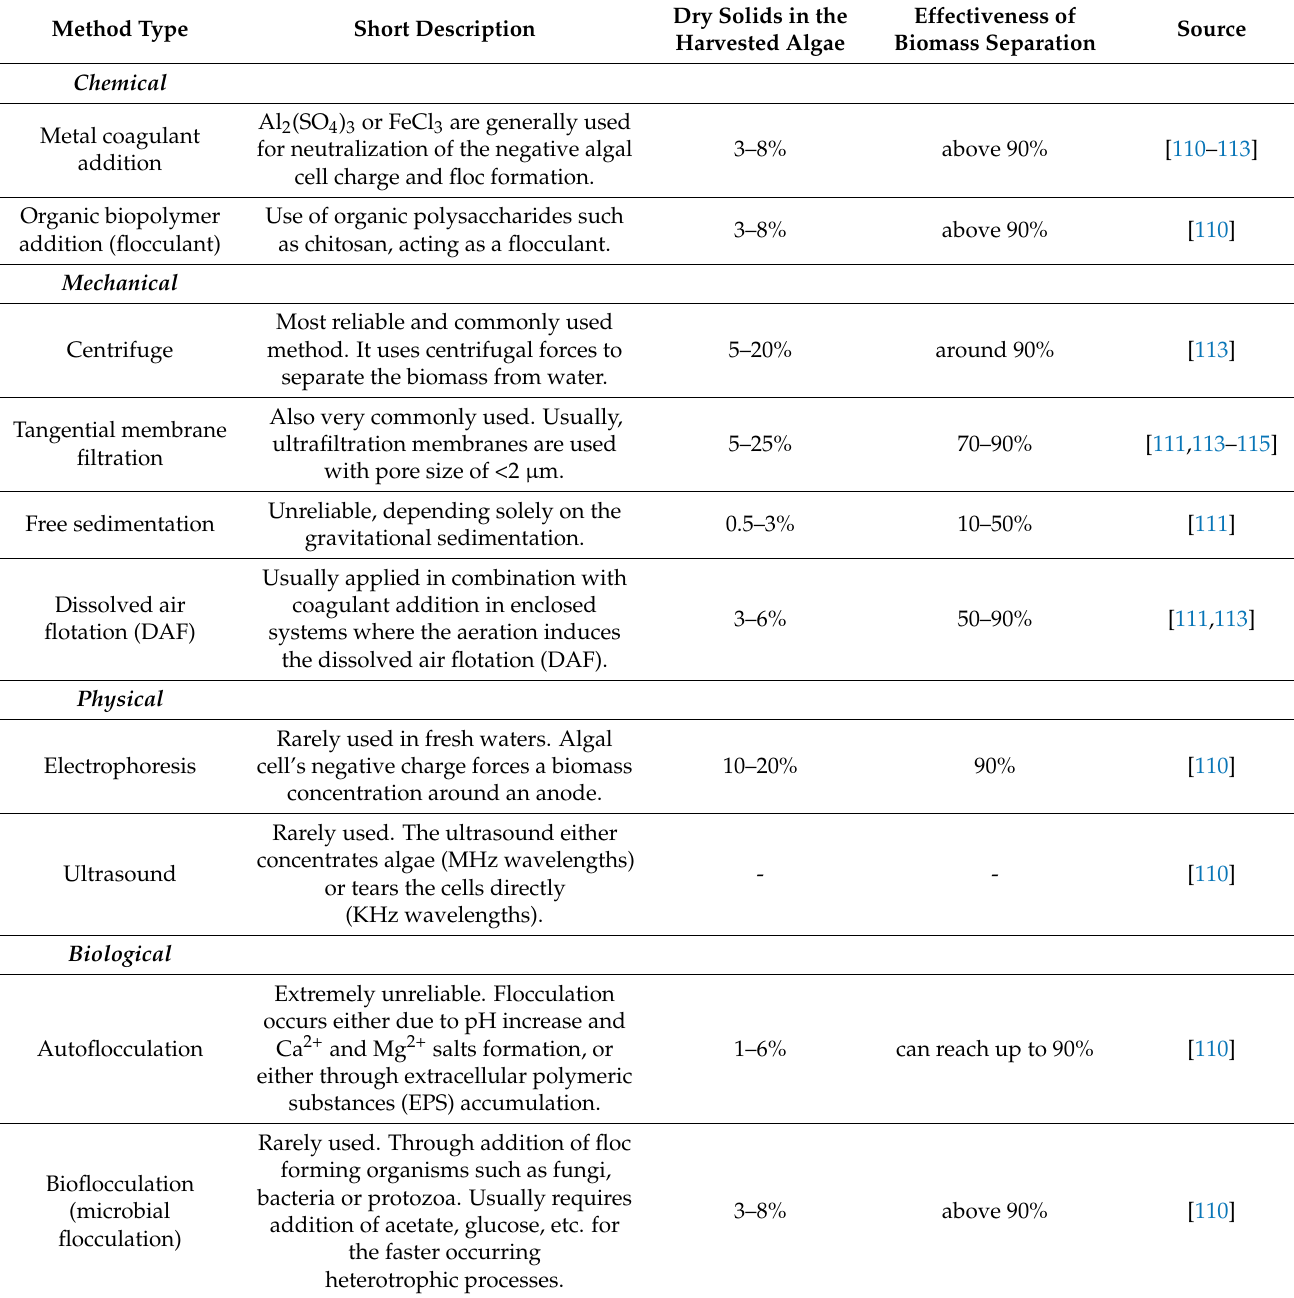
Table 4. Algae harvesting methods for suspended growth